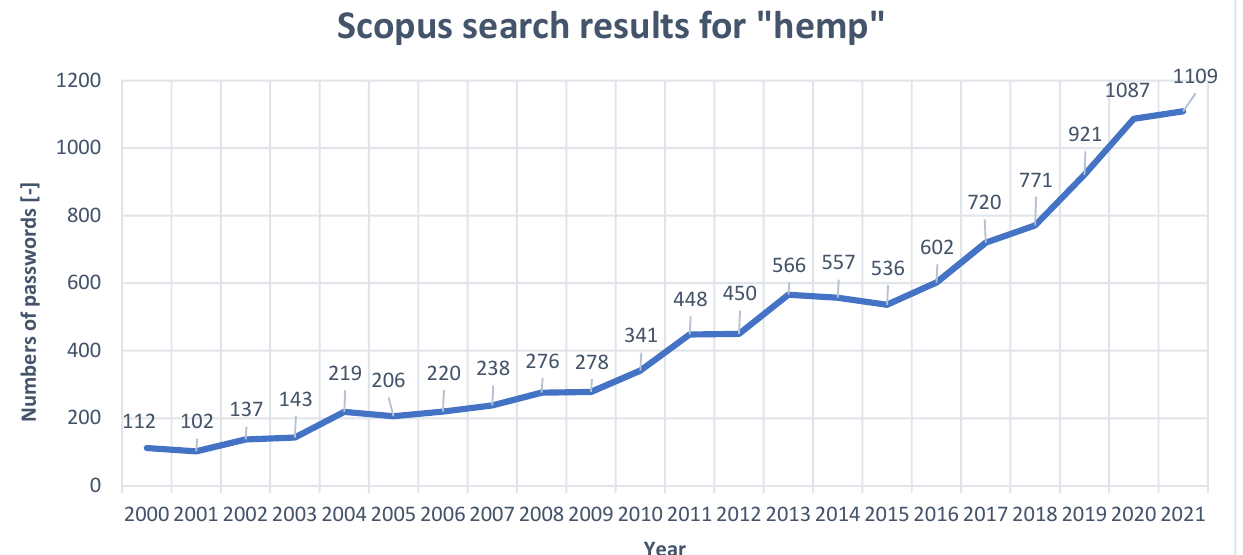
Figure 3. Change in the number of occurrences of the keyword “hemp” in the Scopus database in 2000–2021.